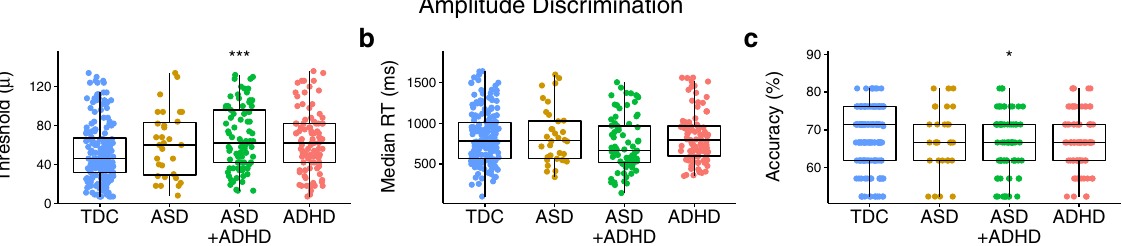
Fig. 3 Group comparisons made on performance outcomes from the amplitude discrimination protocol. Individual data points with overlaid boxplots visualizing the group comparisons on key performance outcomes on the amplitude discrimination protocol, including a amplitude discrimination threshold, b reaction time, and c accuracy. While it appears that all groups have elevated amplitude discrimination thresholds compared to the typically developing control group, after controlling for age, only the ASD + ADHD had signi fi cantly higher amplitude discrimination thresholds than the typically developing control group. Note that all statistical analyses presented in the main text of the manuscript for the plots presented in this fi gure are age-corrected. Values in the plots presented within this fi gure are not corrected for age due to the loss of interpretability of units of measurement that occurs when presenting residual rather than raw values. The precise number of participants in each group and further descriptive statistics can be found in Supplementary Methods, Supplementary Table 1. * p < 0.05, ** p < 0.01, *** p < 0.001, TDC typically developing controls, ASD autism spectrum disorders, ADHD attention- de fi cit hyperactivity disorder, RT reaction times.